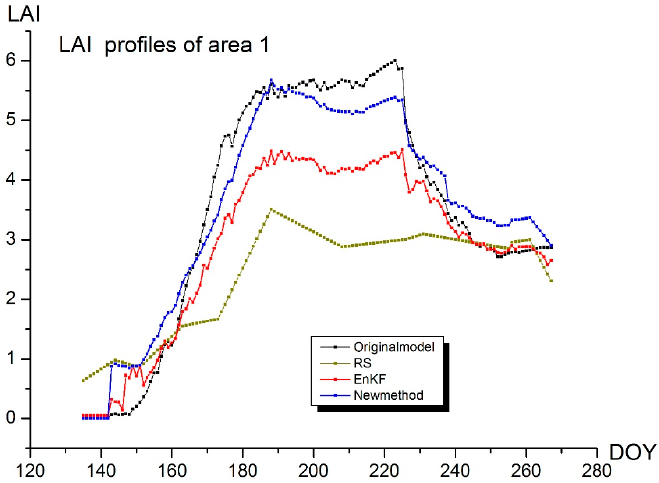
Figure 6. LAI profiles of maize in Hongxing 2014. Table 10. Mean yield value (kg/ha) and relative error of different method.